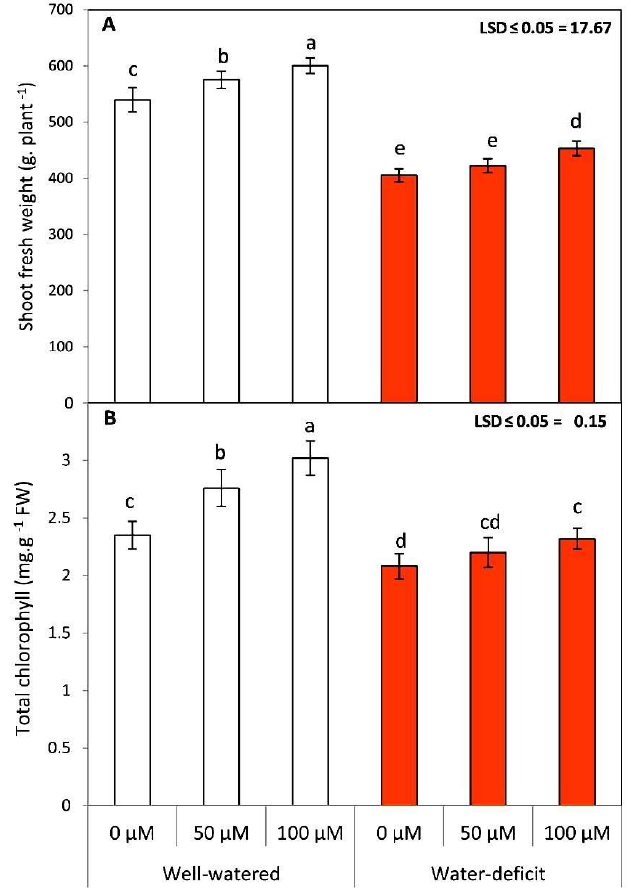
Figure 1. Effects of sodium nitroprusside (SNP) as foliar applications at 0, 50, and 100 µ M on shoot fresh weight and total chlorophyll of tomato plants grown under well-watered and water deficit irrigation. Data followed by the same letters are not significantly different using the LSD multiple rang test at a 5% level.